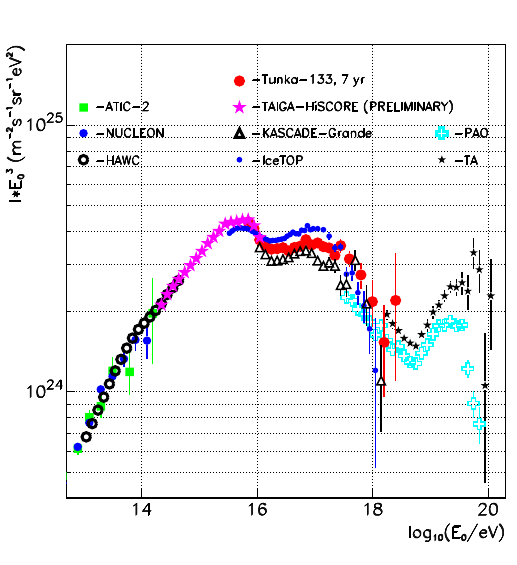
Figure 8. Experimental primary energy spectra by the data of Tunka-133 and TAIGA-HiSCORE arrays.